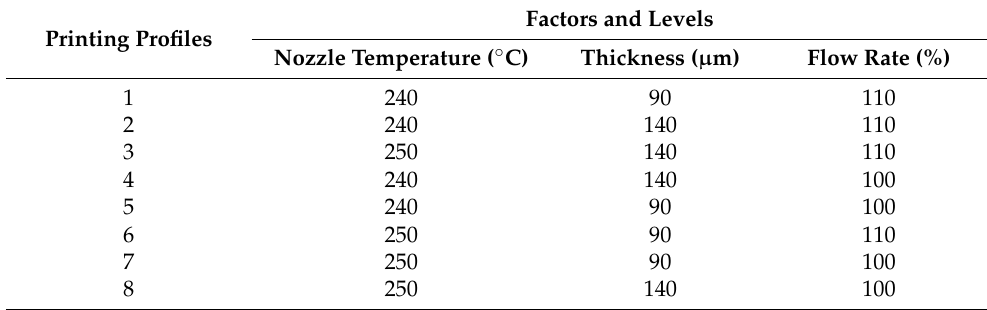
Table 3. Printing profiles set according to the full factorial design.